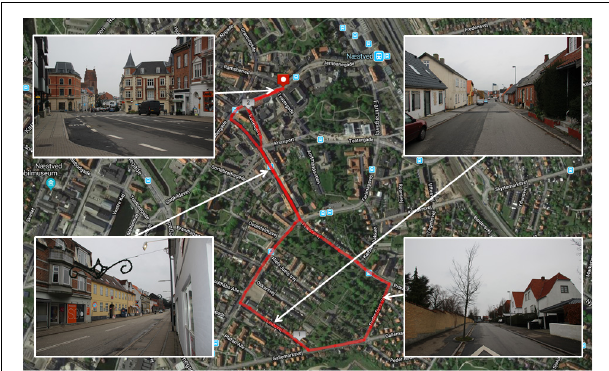
FIGURE 2 | Route map and photographs of the built environment exposure walk. Aerial map of Næstved, Denmark, where the route for the built environment exposure walk was selected (marked in red). A youth centre was the location of the cognitive testing area and the start/end point for the route. The route map was created using MapMyRun (http://www.mapmyrun.com).